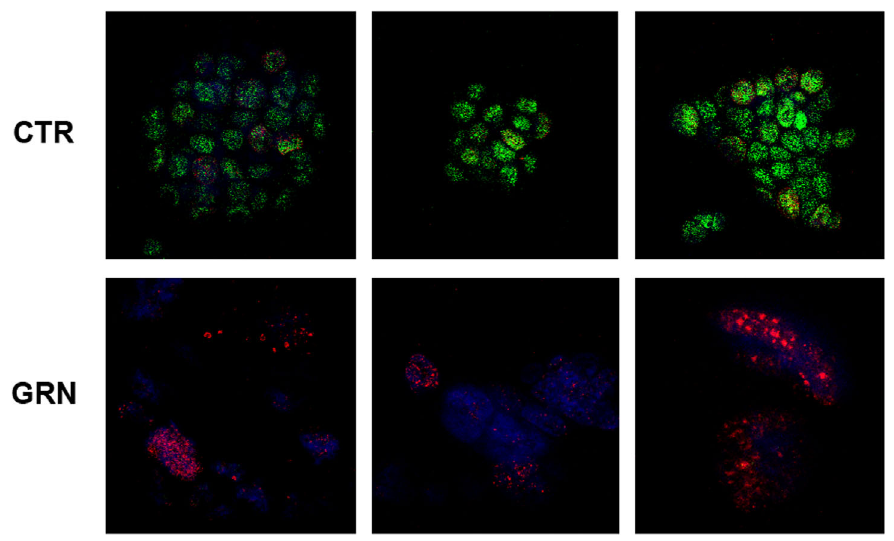
Figure 6. Immunofluorescence analysis of telomeres in the GRN163L-treated CD18 cells. CD18 treated with GRN163L (GRN) or with no drug (CTR) were harvested at the end of the growth curve presented in Figure 3. Cells were fixed and stained with antibodies against TRF2 (green) and c -H2AX (red) and were counter-stained with DAPI (blue). Images were visualized on a confocal microscope (Zeiss 510 Meta Confocal Laser Scanning Microscope). Three representative images of each sample are shown.